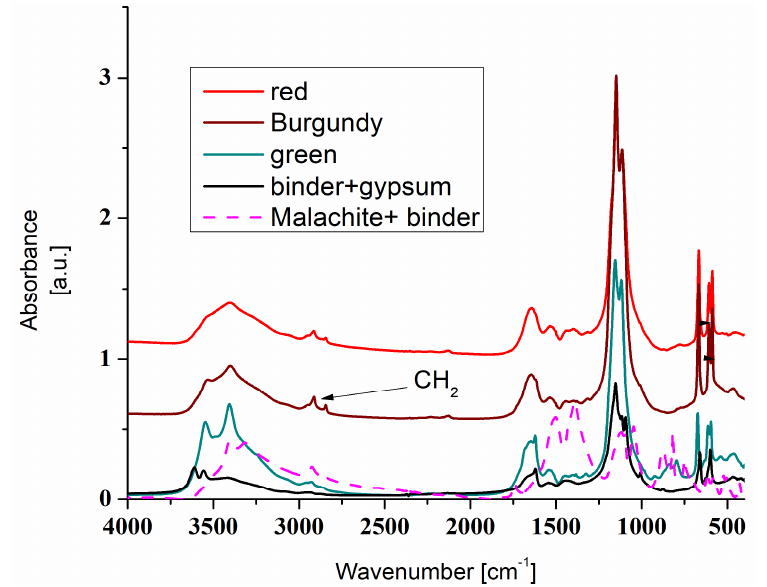
Figure 11. FTIR spectra of the painting materials, 4000 to 400 cm −1 spectral range.